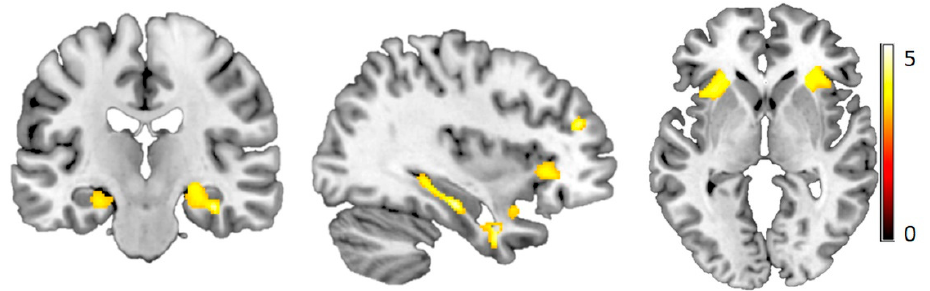
Figure 4. Reduced grey matter in FM. FM showed reduced grey matter density in bilateral insula and hippocampus ([35–19–1], p < 0.001, cluster size = 50), color scale depicts the t -values. Table 2. Regions with reduced grey matter density in FM compared to HC. Age was included as covariate of no interest. T-test at the whole brain level, thresholded at p < 0.001 uncorrected. Region